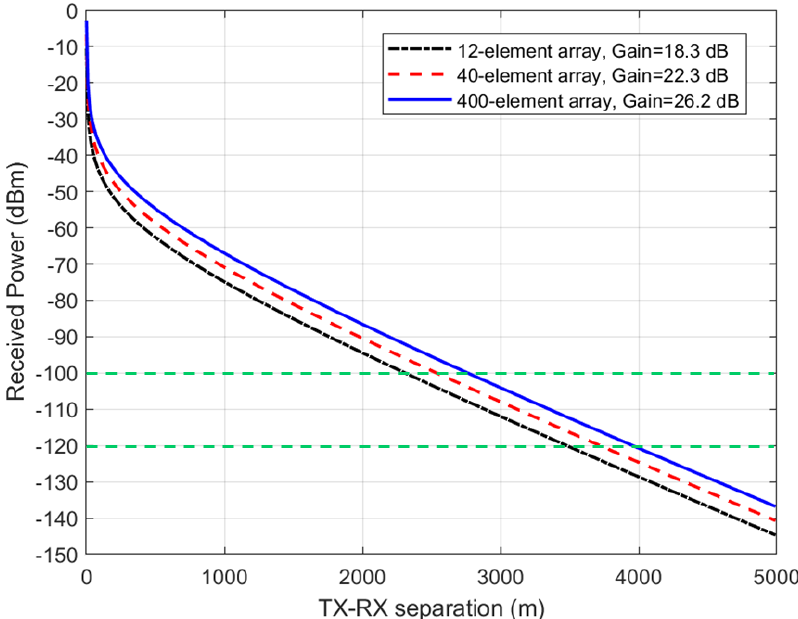
Figure 9. Received power from a BS transmitting 43 dBm (or 20 W) at 60 GHz using the transmitting antenna arrays in Figures